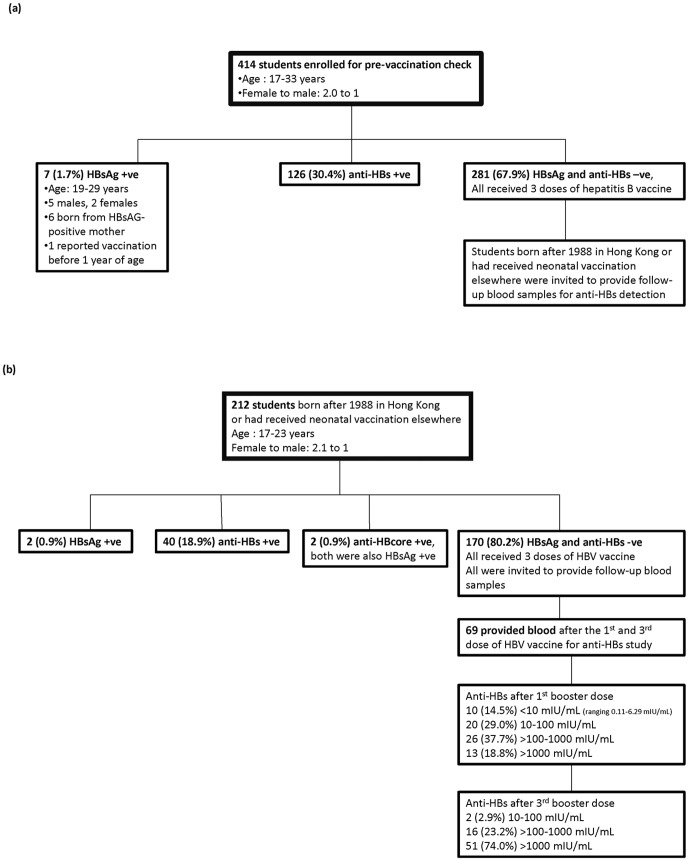
Summary of participant deposition, characteristics and hepatitis B status.(A) Whole cohort of new medical and nursing school entrants. (B) Cohort born after adoption of universal neonatal immunization.